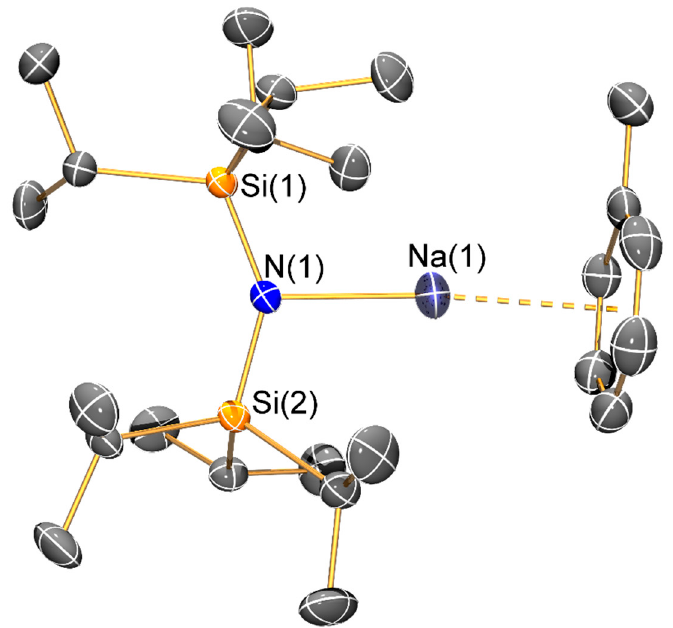
Figure 10. Molecular structure of [Na{N(Si i Pr 3 ) 2 }(C 7 H 8 )] ( 10 ) with selective atom labelling. Displacement ellipsoids set at 30% probability level and hydrogen atoms omitted for clarity. Table 1. Selected bond lengths (Å) and angles ( ◦ ) for 1 –5 and 6 – 10 (M = Li, 6 – 8 ; Na, 9 – 10 ). Distance ( Å )/Angle ( ° ) 1 2 N(1)–Si(1)